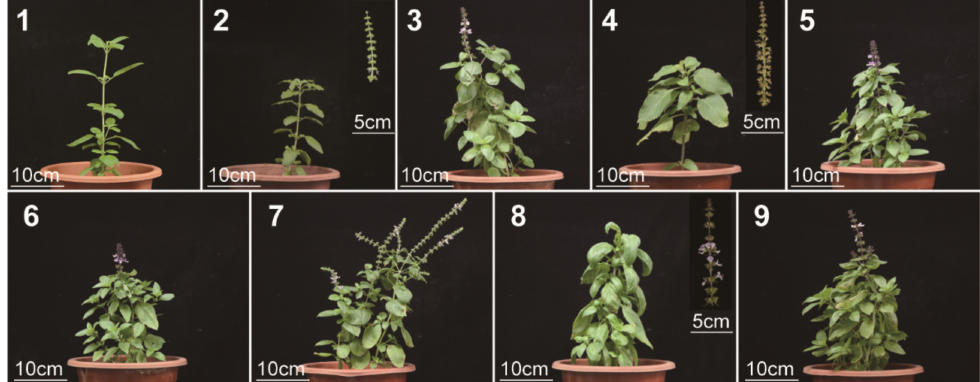
Figure 1. Phenotypes of different Ocimum species. Number 1–9: NO. 1 Ocimum basilicum L.var. pilosum (Willd.) Benth., NO. 2 Ocimum sanctum , NO. 3 Ocimum basilicum cinnamon , NO. 4 Ocimum gratissimum var. suave , NO. 5 Ocimum tashiroi , NO. 6 Ocimum basilicum , NO. 7 Ocimum americanum , NO. 8 Ocimum basilicum ct linalool, and NO. 9 Ocimum basilicum var. basilicum ,